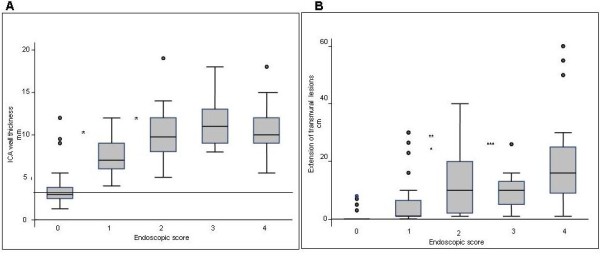
A. Box-and-whiskers plots of wall thickness at the level of ileo-colonic anastomosis according to different Rutgeerts score. The boxes at each score extend from the 25th percentile (x[25]) to the 75th percentile (x[75]) [i.e., the interquartile range (IQ)]; the lines inside the boxes represent the median values. The line emerging from the boxes (i.e., the "whiskers") extend to the upper and lower adjacent values. The upper adjacent value is defined as the largest data point ≤x[75] + 1.5 × IQ, and the lower adjacent value is defined as the smallest data point ≥x[25] - 1.5 × IQ. Observed values more extreme than the adjacent values, if any, are individually plotted (circles). * p < 0.001 score 1 vs score 0, 2-4. The horizontal line indicates the cut-off value of 3.5 mm. B. Box-and-whiskers plots of extension of intramural lesion at the level of neo-terminal ileum according different Rutgeerts score. The boxes at each time unit extend from the 25th percentile (x[25]) to the 75th percentile (x[75]) [i.e., the interquartile range (IQ)]; the lines inside the boxes represent the median values. The line emerging from the boxes (i.e., the "whiskers") extend to the upper and lower adjacent values. The upper adjacent value is defined as the largest data point ≤x[75] + 1.5 × IQ, and the lower adjacent value is defined as the smallest data point ≥x[25] - 1.5 × IQ. Observed values more extreme than the adjacent values, if any, are individually plotted (circles). * p < 0.001 score 1 vs score 4, ** p = 0.03 score 1 vs score 2, *** p = 0.04 score 1 vs score 3